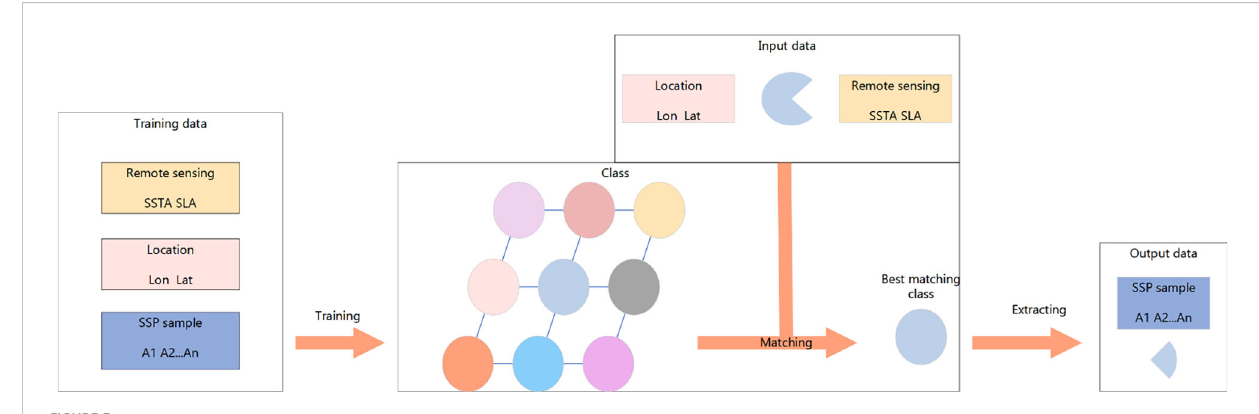
FIGURE 3 SOM algorithm inversion